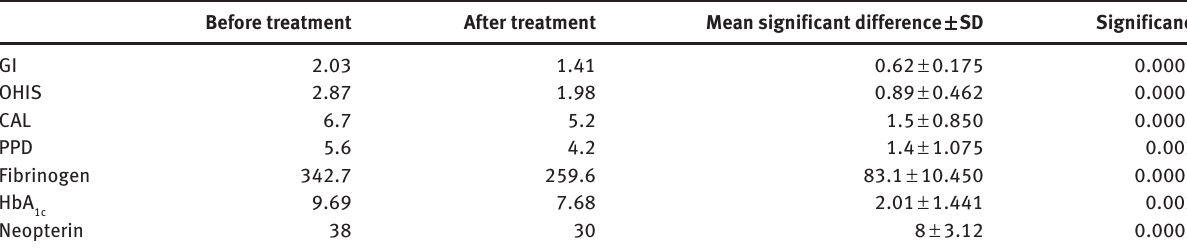
Table 1: Intragroup comparison of all variables before and after treatment in group CP + D.